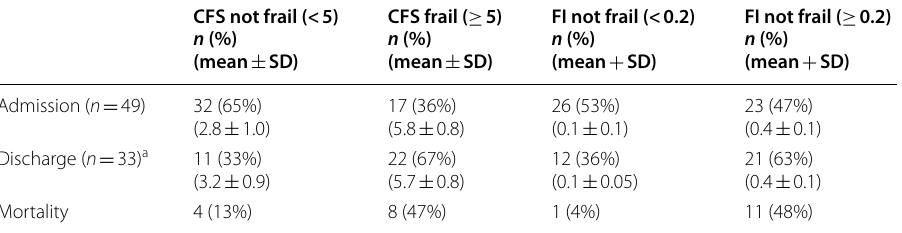
CFS clinical frailty Scale, FI frailty index